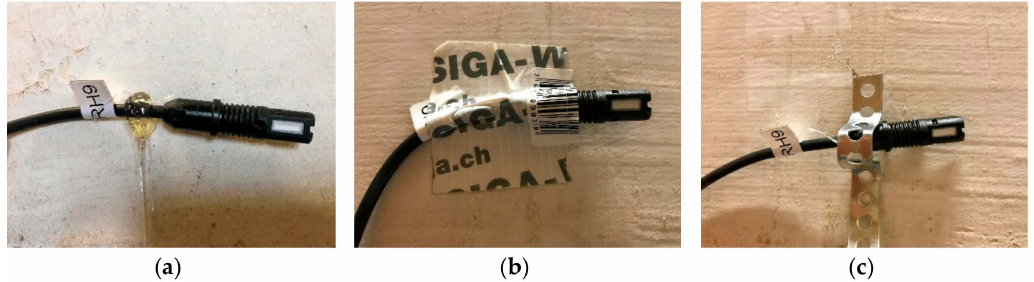
Figure 7. Di ff erent mounting systems used for contact monitoring: ( a ) Glues; ( b ) tape; ( c ) nails and holder (Photos by E. Lucchi).